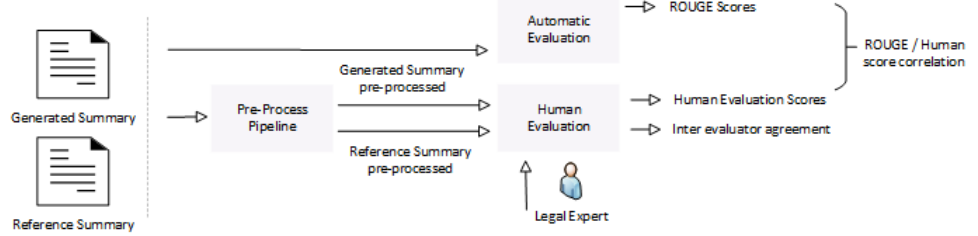
Figure 7. A schema of the human evaluation pipeline. Reference summaries were pre-processed to match the BERT-generated summaries. Human evaluation metrics were used to measure the relevance, consistency, coherence, and fluency of the produced summaries and capture the inter- evaluator